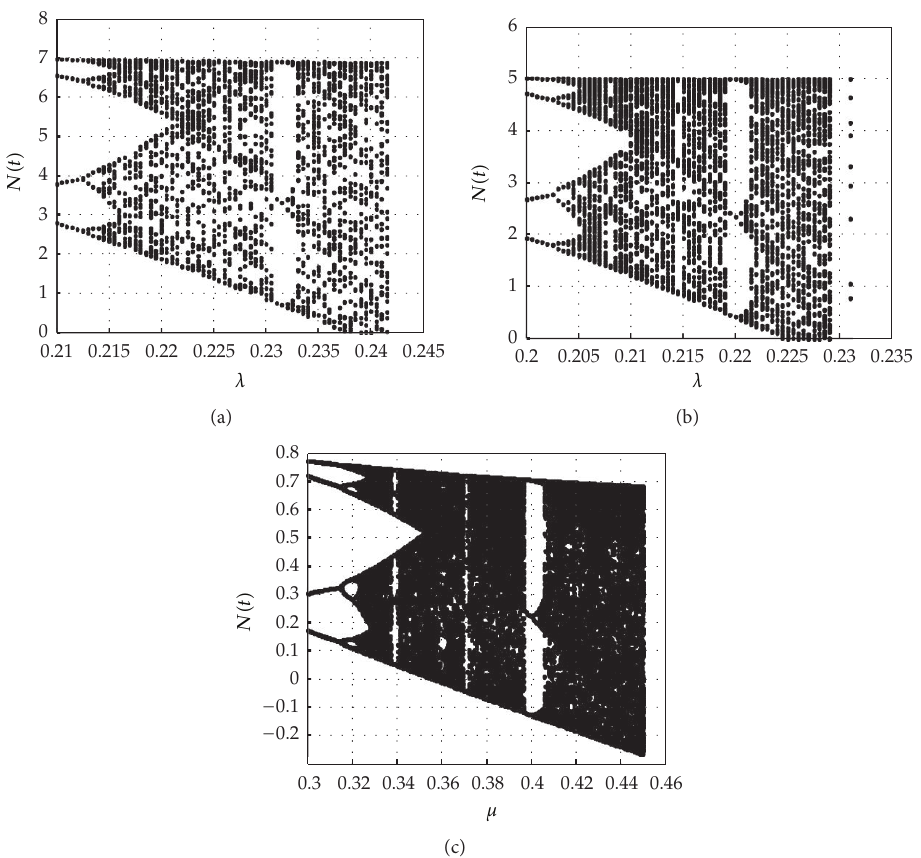
Figure 8: (a) The bifurcation diagram in the chaos area when 𝜇 = 0.01 ; (b) the bifurcation diagram in the chaos area when 𝜇 = 0.015 ; (c) the bifurcation diagram in the chaos area when 𝜆 = 0.1